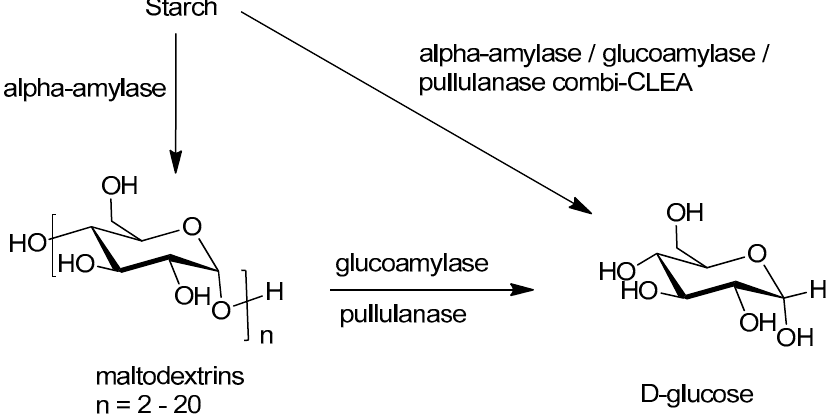
Figure 11. One-pot starch hydrolysis with a combi-CLEA.